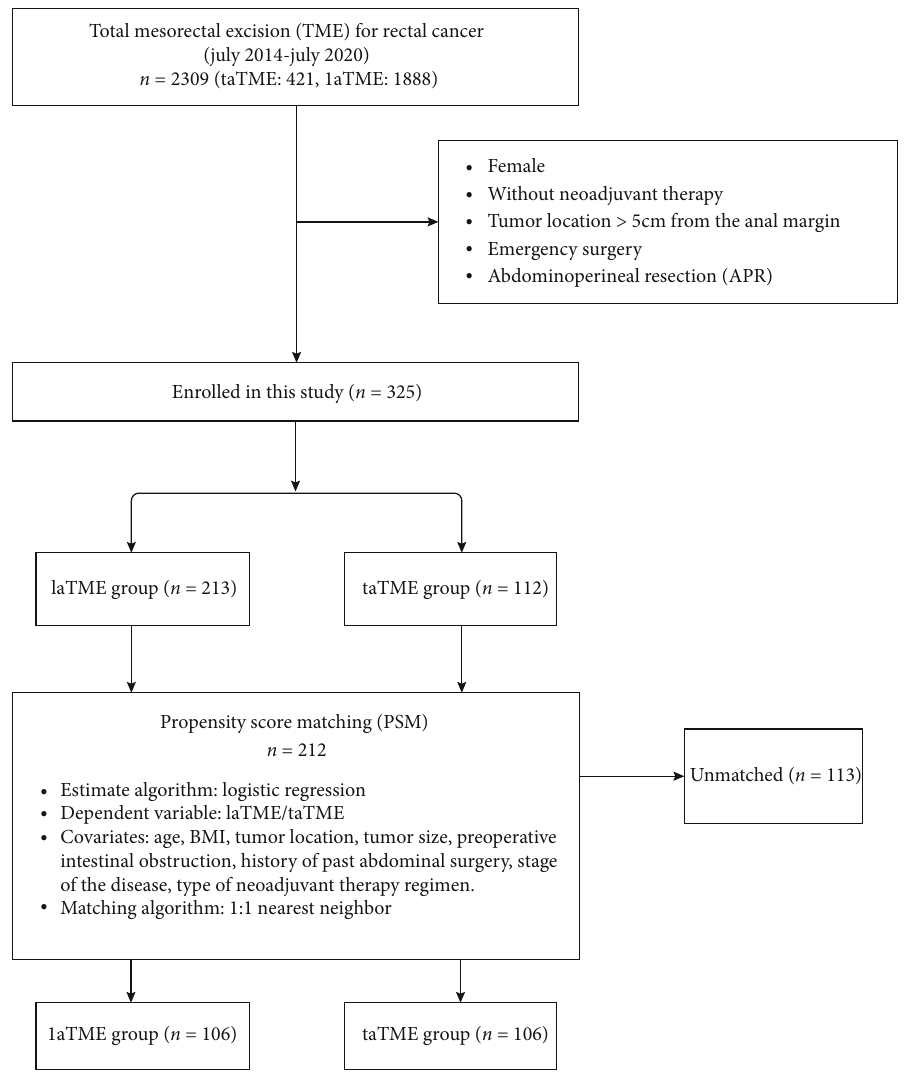
Figure 2: Flow chart of patient